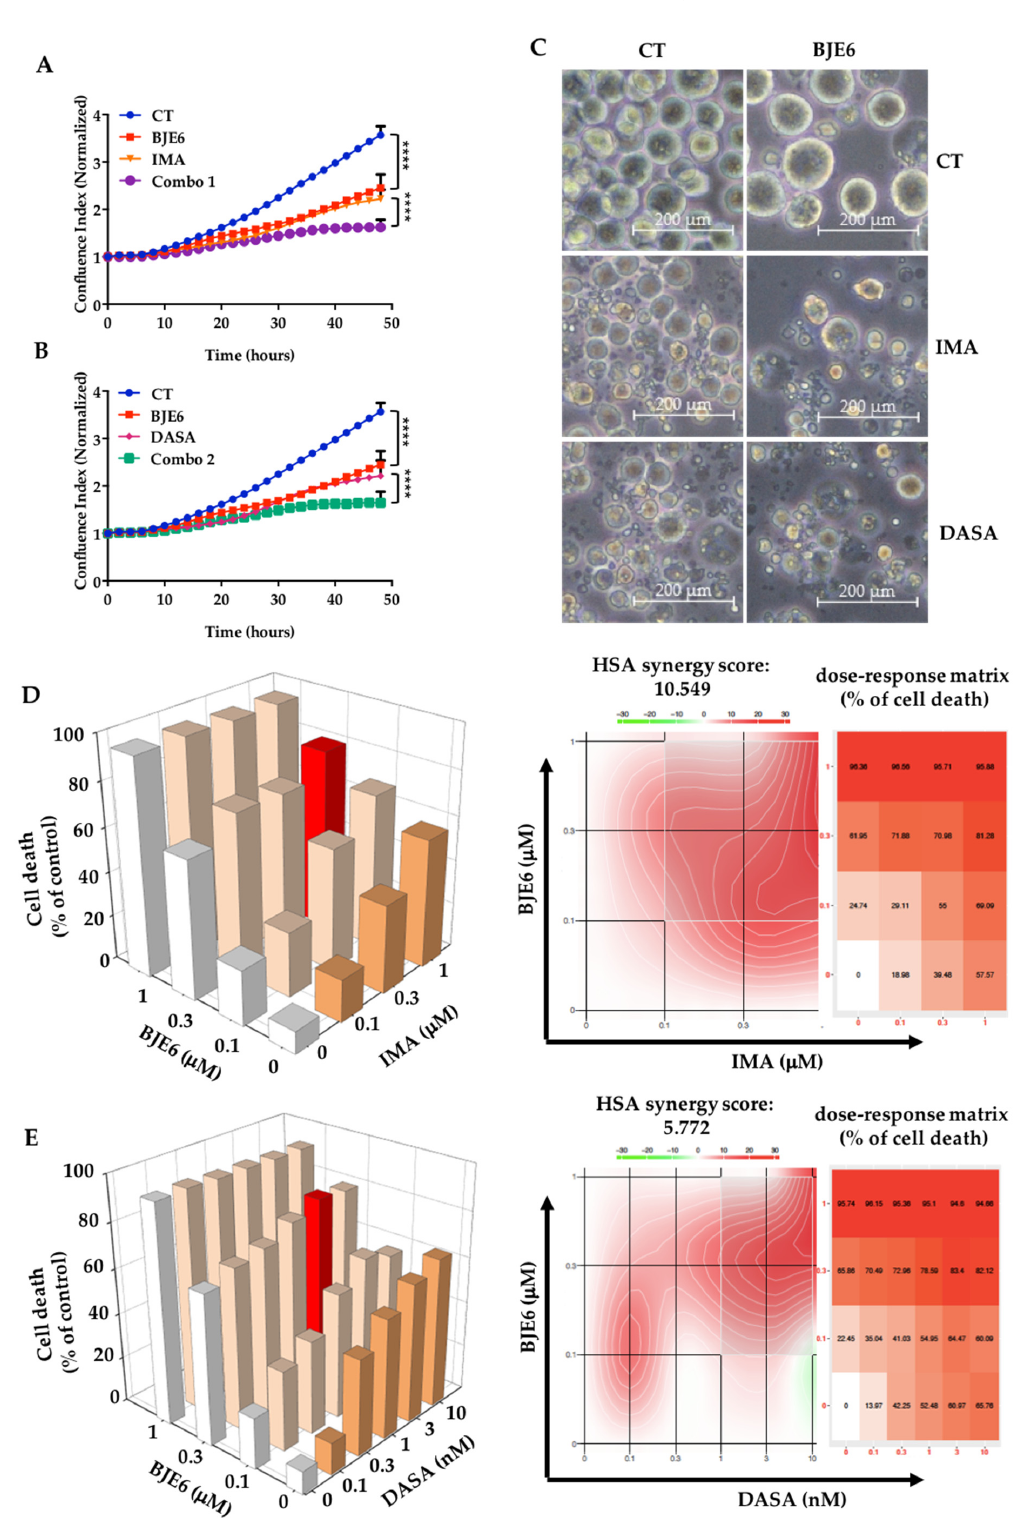
Figure 3. Targeting PKC δ synergized with TKIs to inhibit proliferation and induce cell death of K562 cells. ( A , B ) Proliferation curves for K562 cells treated with DMSO (CT), 0.1 µ M BJE6, 1 µ M IMA, BJE6 and IMA combined (Combo 1), or BJE6 and DASA combined (Combo 2) for 48 h. Time-lapse analysis of K562 cells by phase-contrast microscopy using IncuCyte